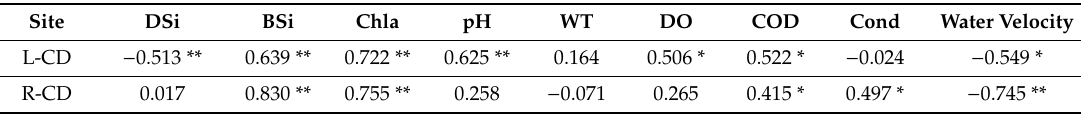
Table 2. Spearman correlation between cell density and environmental parameters (dissolved silicon (DSi), biogenic silicon (BSi), chlorophyll a (Chl a), pH, water temperature (WT), dissolved oxygen (DO), chemical oxygen demand (COD), conductivity (Cond), and water velocity) in the lacustrine zone (L-CD) and riverine zone